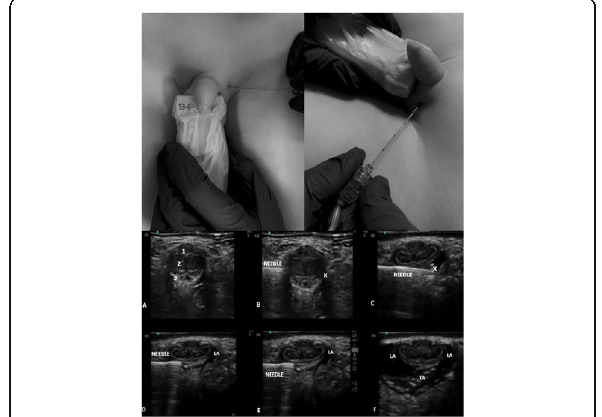
Fig. 1 (abstract A39). R-US-DPNB technique performed using a linear ultrasound probe (13-6 MHz, 38mm, SonoSite). The corpus spongiosum (1). The two corpora cavernosa (2). Arteries, veins, and the two dorsal nerves of the penis run within the Buck ’ s fascia (3). X: target. LA: local